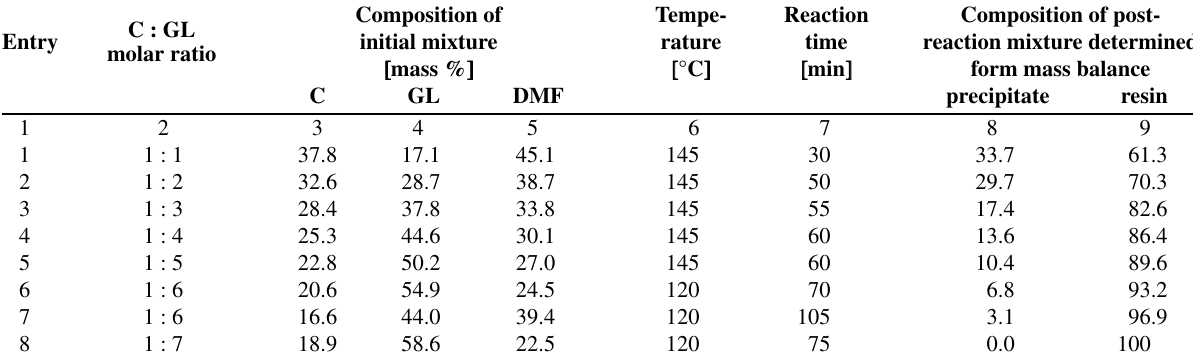
Table 1. Analysis of reaction progress and products of reaction between carbazole and glycidol